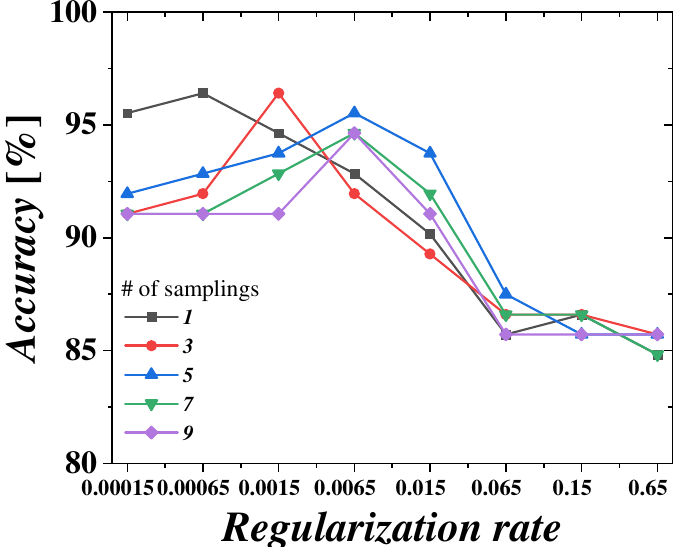
Figure 11. Validation data accuracy vs. regularization rate of the STM-LSTM-based fall detection system with respect to different sampling intervals.